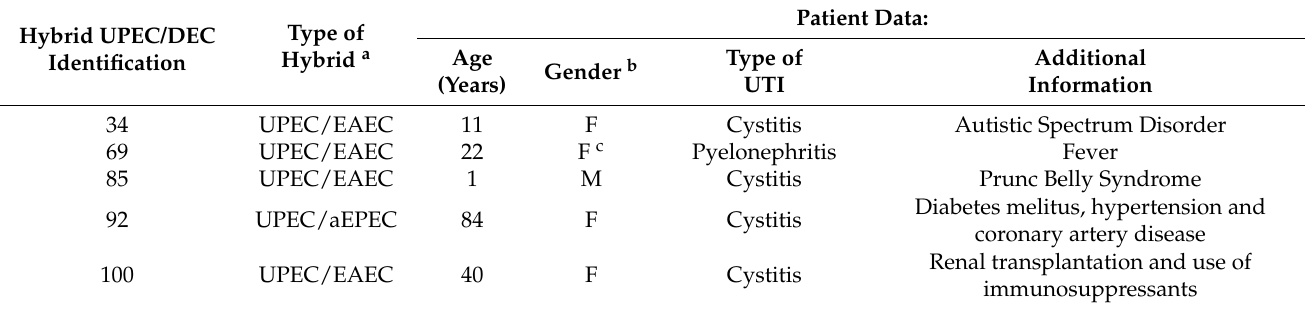
Table 3. Age, gender, type of urinary tract infection (UTI) and additional relevant clinical information from patients diagnosed with UTIs from which hybrid isolates of uropathogenic and diarrheagenic (UPEC/DEC) E. coli were